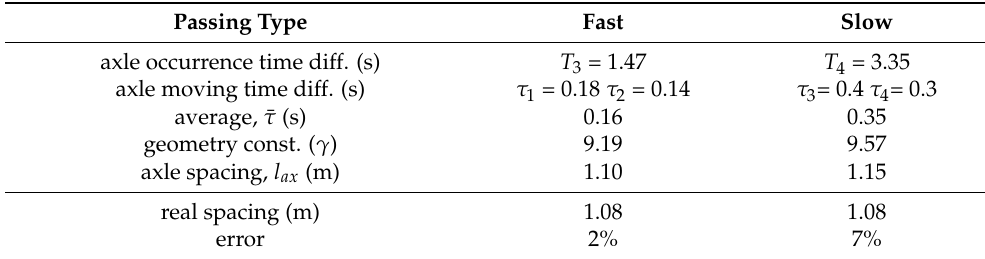
Table 4. Bicycle geometry characterization according to the loaded passings. T denotes the time period between axle occurrences on the pavement and τ i denotes the time shift between recordings coming from different segments of